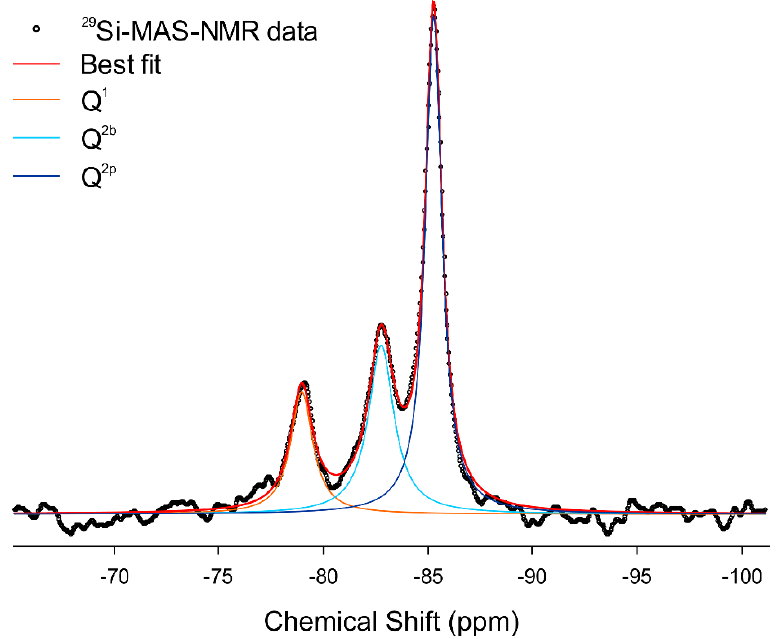
Figure 3. Solid-state 29 Si MAS-NMR data (black dots) of Me-S-H sample and best fit (red line). Spectral deconvolution (R 2 = 0.9936) was performed using three peaks at − 78.96, − 82.78 and − 85.28 ppm attributed to Q 1 , Q 2b and Q 2p silicate tetrahedra, respectively.